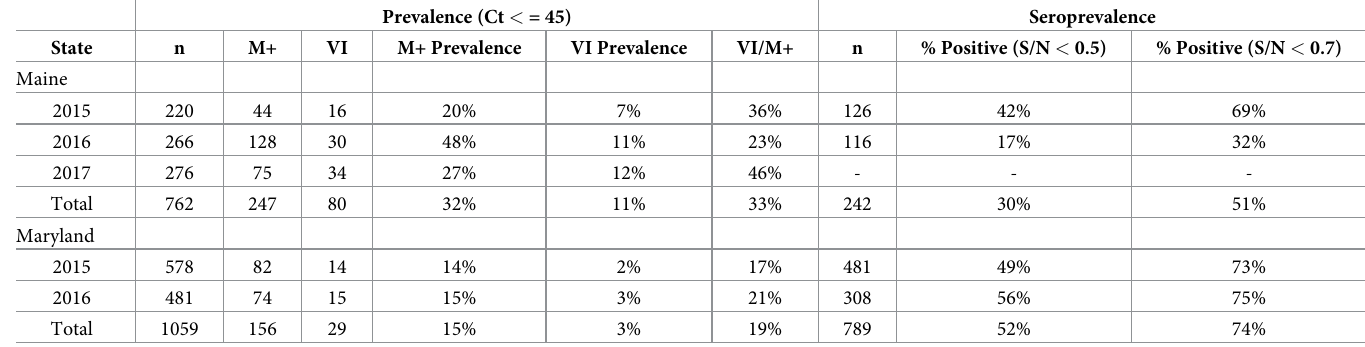
Table 1. Prevalence and seroprevalence of influenza A virus for wild dabbling ducks sampled in Maine and Maryland from 2015–2017. Prevalence identified using rRT-PCR (M+, Ct values � 45) and virus isolation (VI). Seroprevalence (avian influenza antibodies) identified using bELISA with serum-to-negative control (S/N) ratios < 0.5 and 0.7. Dashes indicate no data was